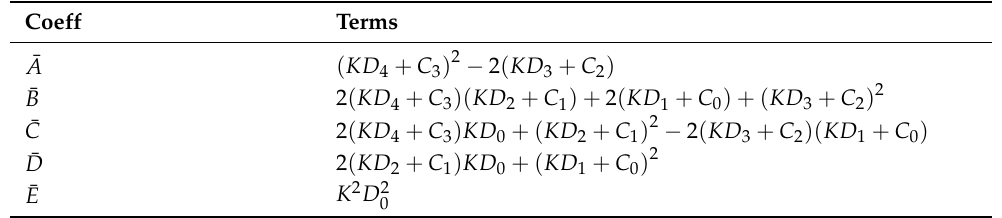
Table 4. Denominator optimisation